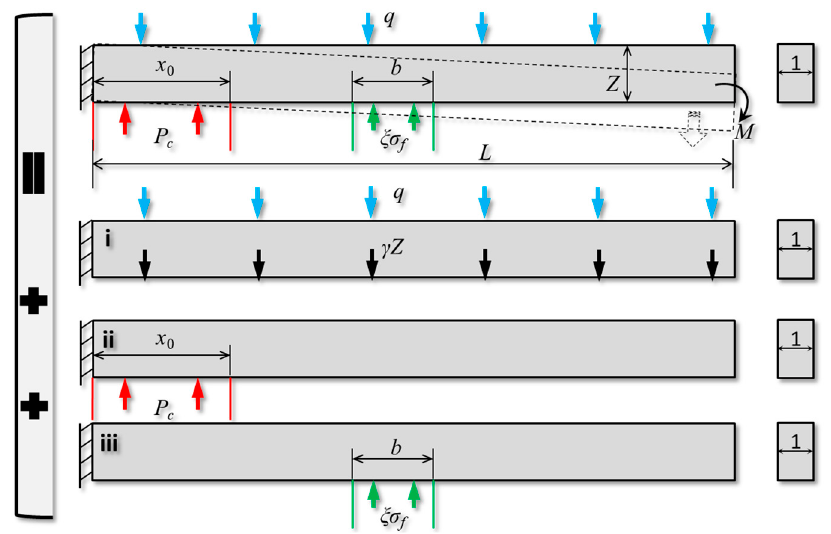
Figure 8. Initial mechanical model.